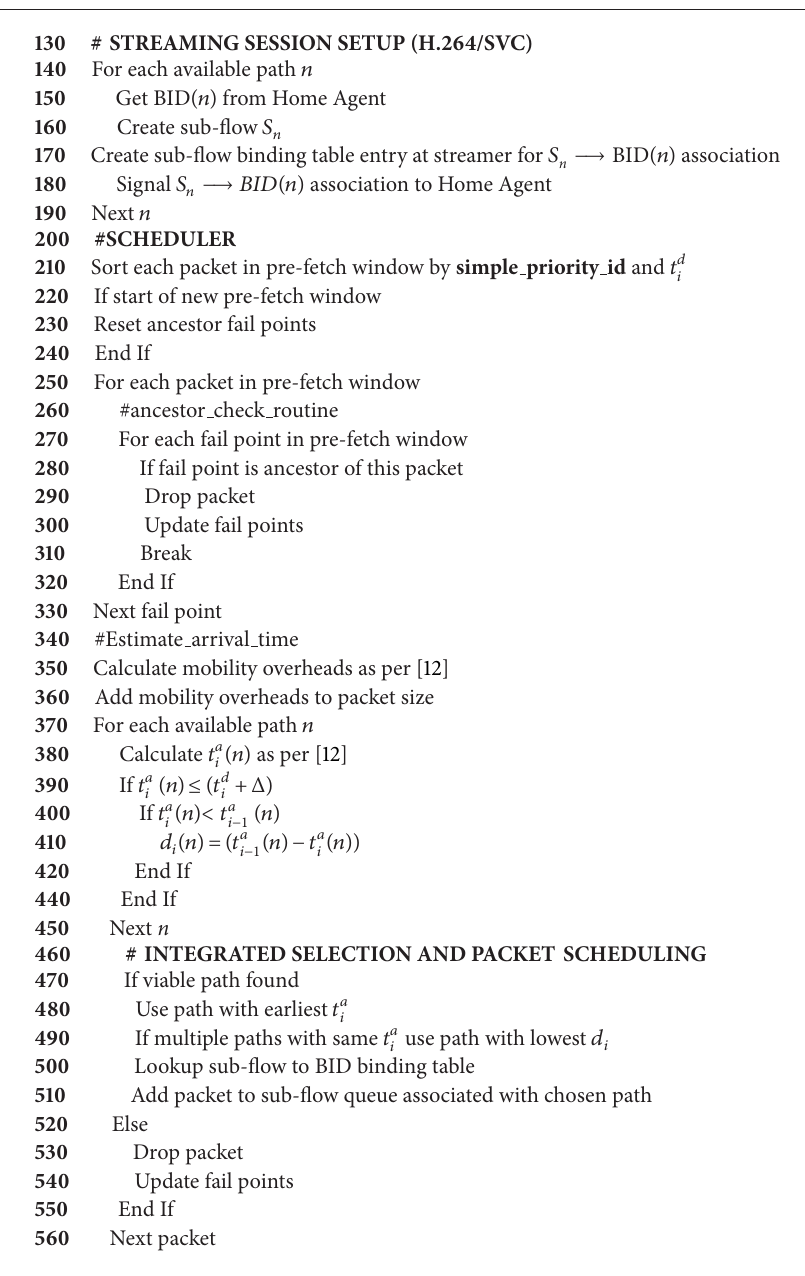
Algorithm 3: Main algorithm of the streaming framework incorporating CMT-NEMO, path selection, and packet scheduling (H.264/SVC